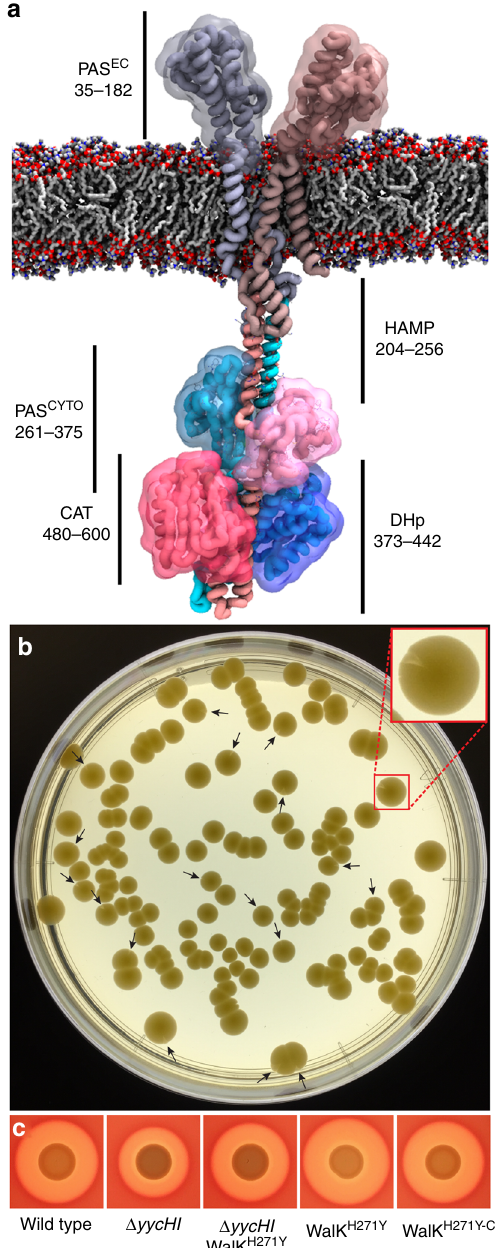
Fig. 1 Colony sectoring in a Δ yycHI leads to mutation in WalK. a Molecular model of the essential two-component histidine kinase WalK (dimer 608 residues) from S. aureus in a phospholipid bilayer. The amino acid boundaries of the various WalK domains (PAS EC : extracellular PAS, HAMP: present in Histidine kinases, Adenylate cyclases, Methyl accepting proteins and Phosphatases, PAS CYT : cytoplasmic PAS, DHp: dimerisation and histidine phosphorylation, CAT: catalytic/ATP binding) are highlighted. b Plating of NRS384 Δ yycHI onto Brain Heart Infusion agar after 48 h at 37 °C promotes colony sectoring (arrow heads). Red box inset shows enlarged view of one sectored colony. c The WalK H271Y mutation identi fi ed from whole-genome sequencing of a single sectored colony was introduced by allelic exchange into the NRS384 background, with the mutation increasing haemolysis on sheep blood agar. Also shown are the wild- type (NRS384), Δ yycHI , Δ yycHI WalK H271Y and the WalK H271Y-COMP ,